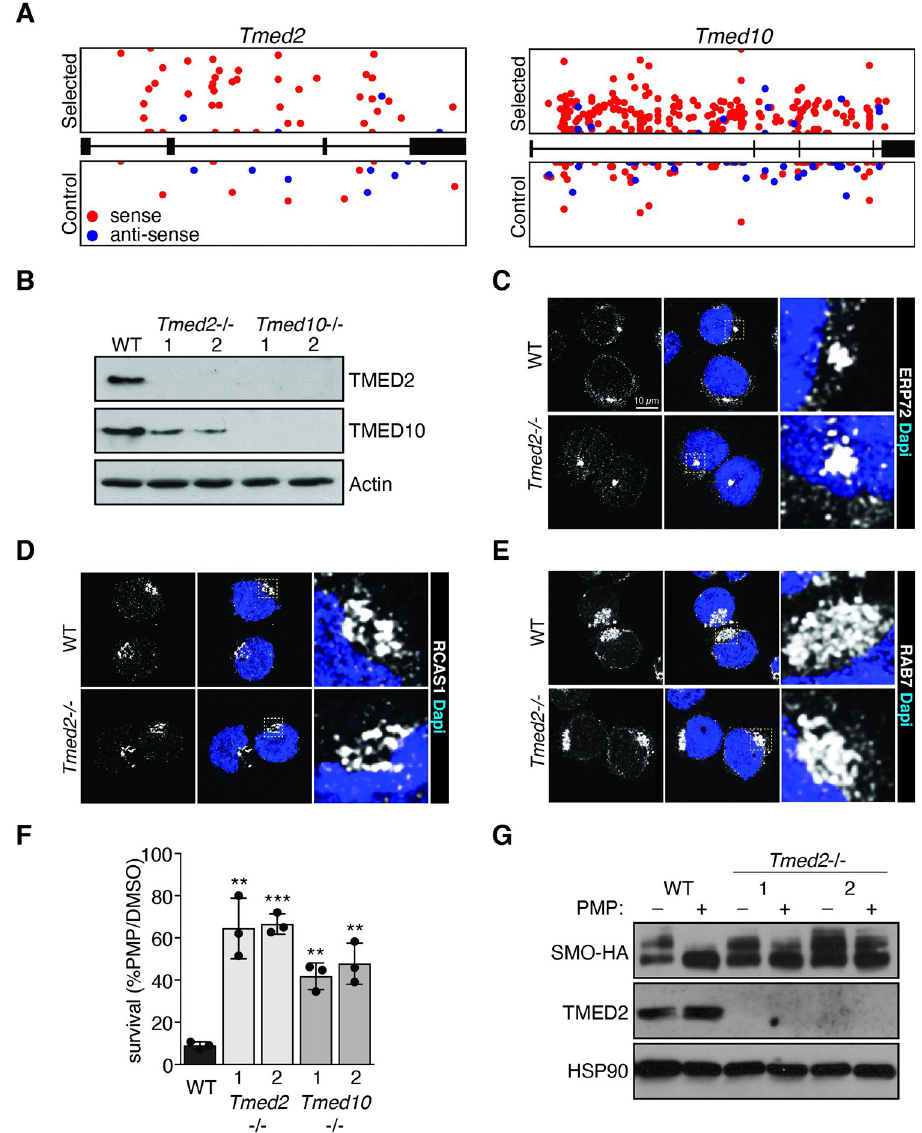
Fig 3. Identification of TMED2 as a new modulator of HH signaling. (A) Distribution of I.I. within Tmed2 and Tmed10 in PMP selected (top) and control (bottom) samples. (B) Western analysis of parental control (WT) and 2 clones of Tmed2 and Tmed10 mutant ESCs. (C–E) Immunofluorescence staining (C) ERP72 (ER marker), (D) RCAS1 (Golgi marker), and (E) RAB7 (LE marker) in WT and Tmed2 −/− ESCs. Scale bar = 10 μ m. Samples were analyzed using conventional FM. (F) Tmed2 and Tmed10 mutations confer PMP resistance. Survival of Tmed2 and Tmed10 mutant ESCs after PMP treatment. Asterisks denote statistical significance for difference from the WT sample. (G) SMO–HA protein levels in WT and Tmed2 −/− ESCs. Western analysis of cells treated with or without PMP for 24 hours. The data underlying all the graphs shown in the figure are included in the S1 Data file. ER, endoplasmic reticulum; ESC, embryonic stem cell; FM, fluorescence microscopy; HA, hemagglutinin; HH, hedgehog; I.I., independent insertion; LE, late endosome; PMP, purmorphamine; SMO, Smoothened; WT, wild-type.